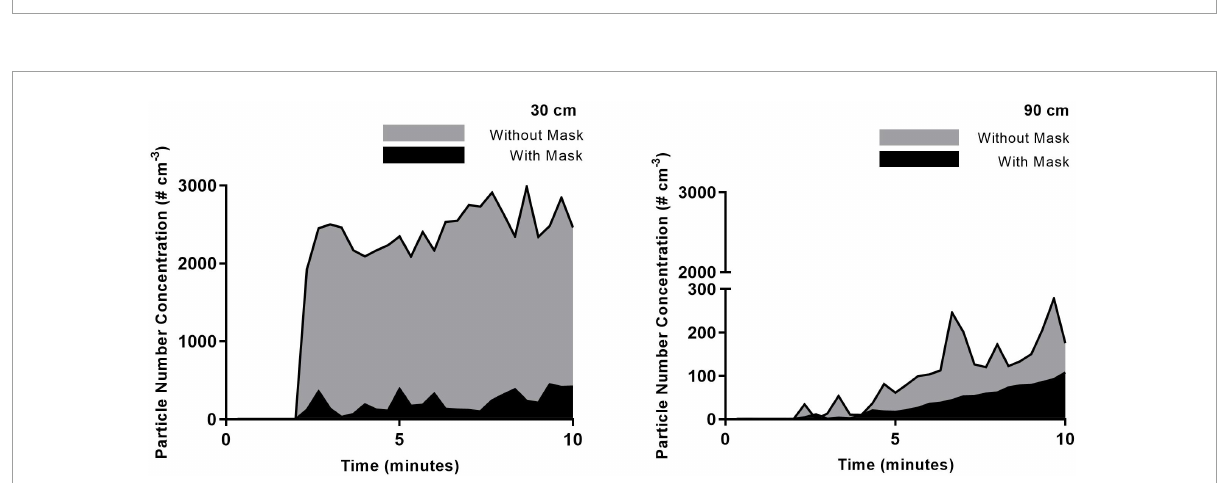
FIGURE3 30 L/min HFNC with and without mask. Averaged time-series PNC for the three runs recorded at a distance of 30 and 90 cm from the simulated patient. Each trendline represents the data averaged across 20 s intervals.